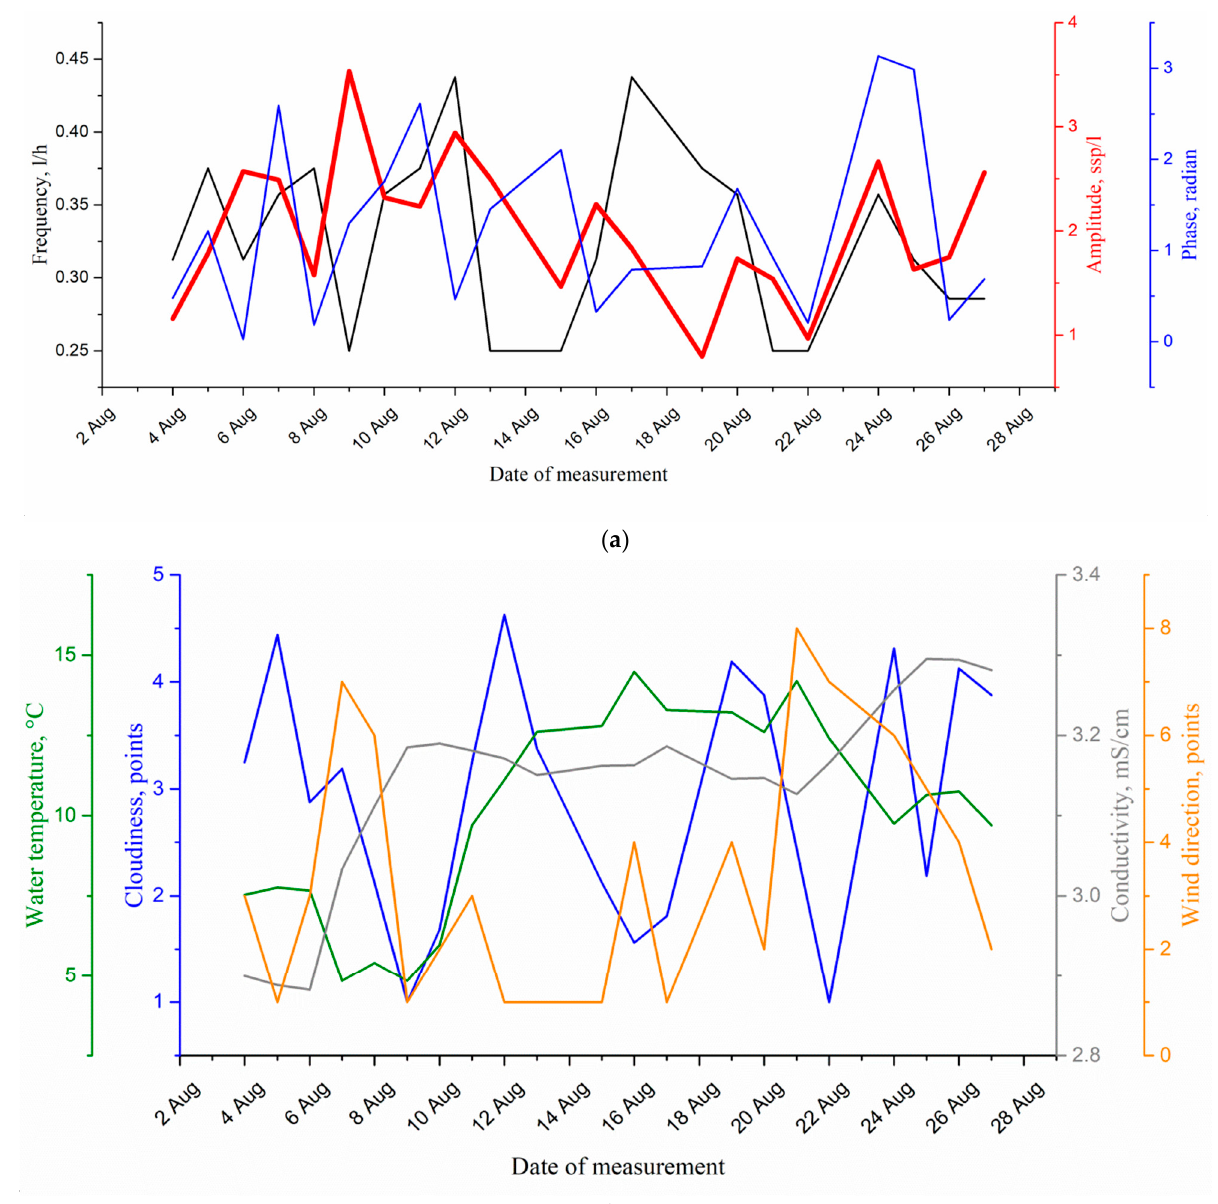
Figure 11. ( a )—parameters of the ultradian rhythm (4 h) of coastal plankton over a period from 3 August 2021 to 27 August 2021; ( b )—habitat characteristics: wind direction, cloudiness, water temperature, water conductivity. Bolshiye Koty mooring station.